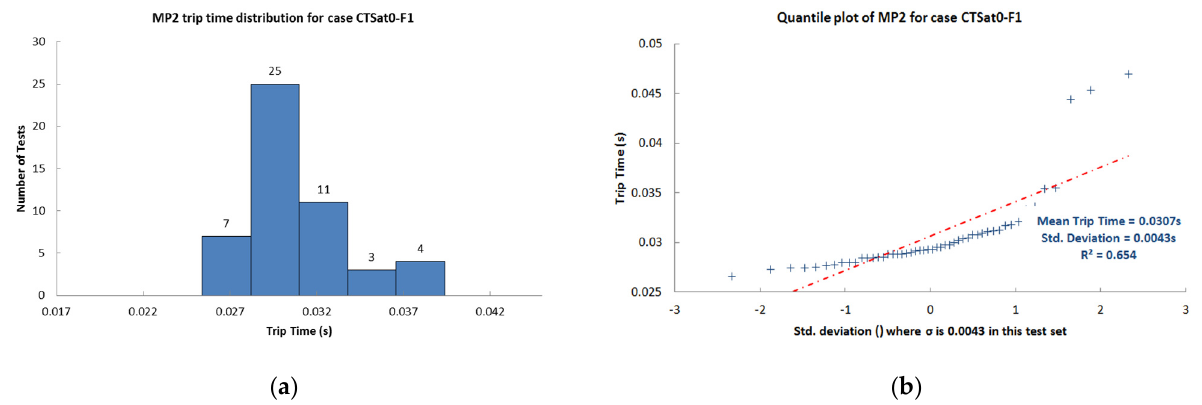
Figure 26. MP2 trip time distributions and quantile plot for case CTSat0-F1 (ideal CT, 1 faulty AMU+ 1 faulty fibre, 3Ph-G fault at 50% of the feeder).